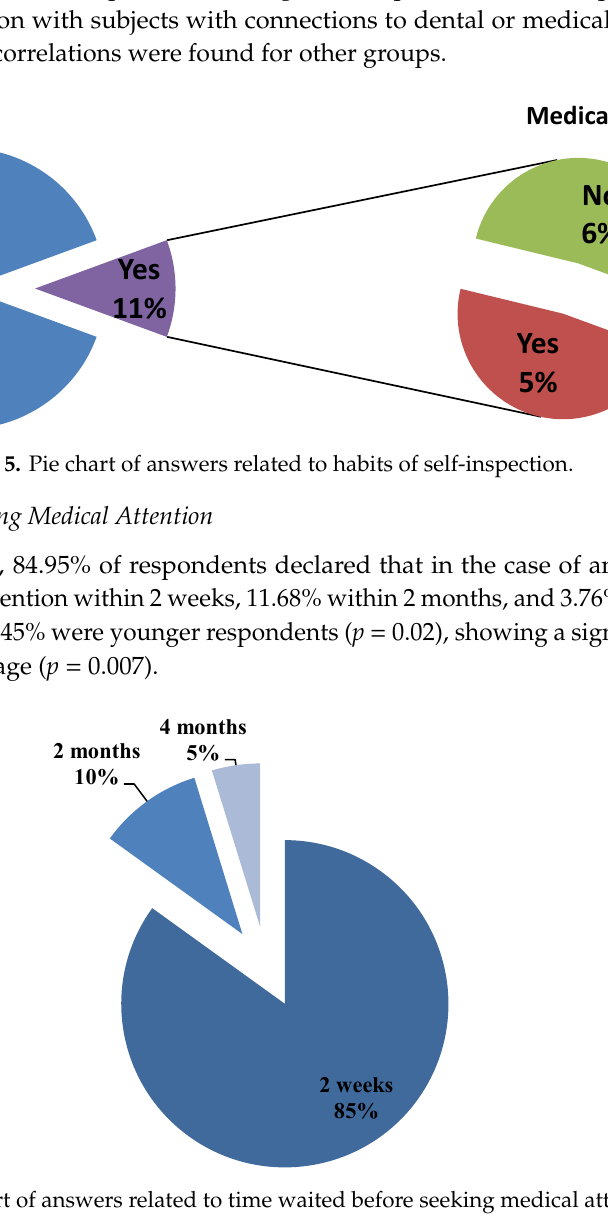
Figure 6. Pie chart of answers related to time waited before seeking medical attention .